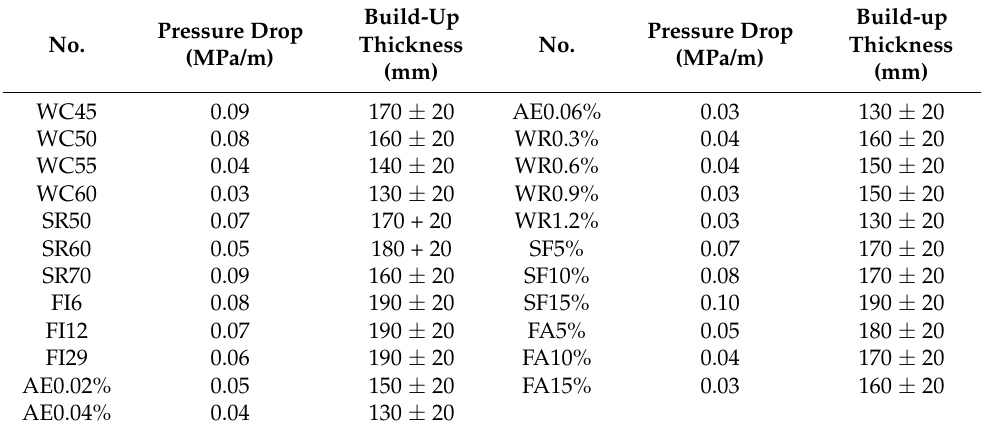
Table 3. Results of pumpability and shootability tests of fresh